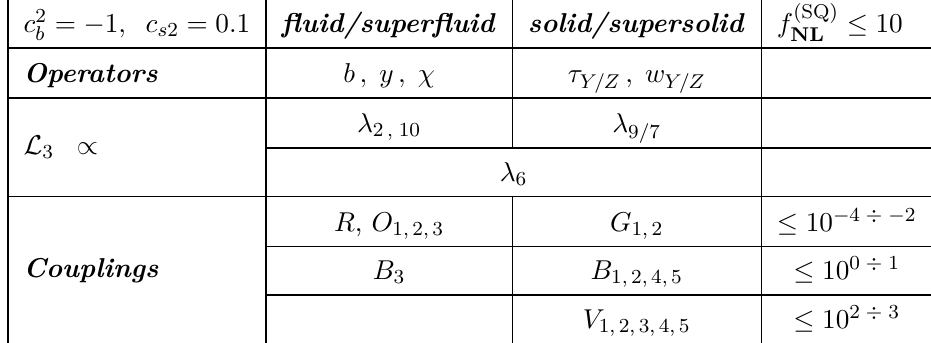
Table 7 . Operators in the cubic SSS Lagrangian classified